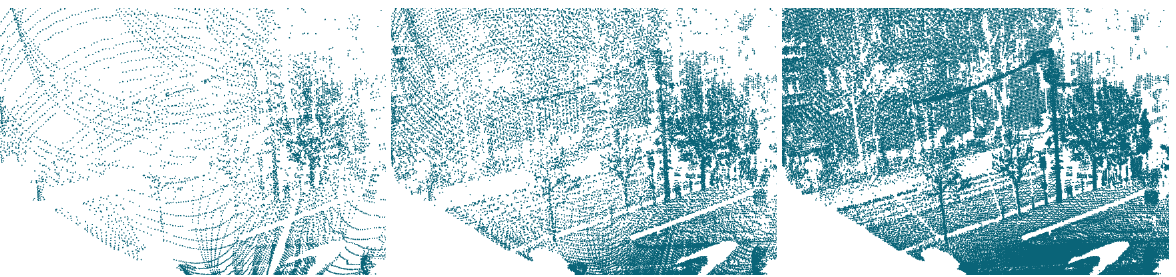
(a) Detected foreground (by red) in a single time frame of the (b) Detected foreground regions (by red) displayed over the NRCS Lidar sequence generated high-resolution background point cloud Figure 6. Foreground detection results (by red) in the City Center scene, displayed in 3D point cloud representation.